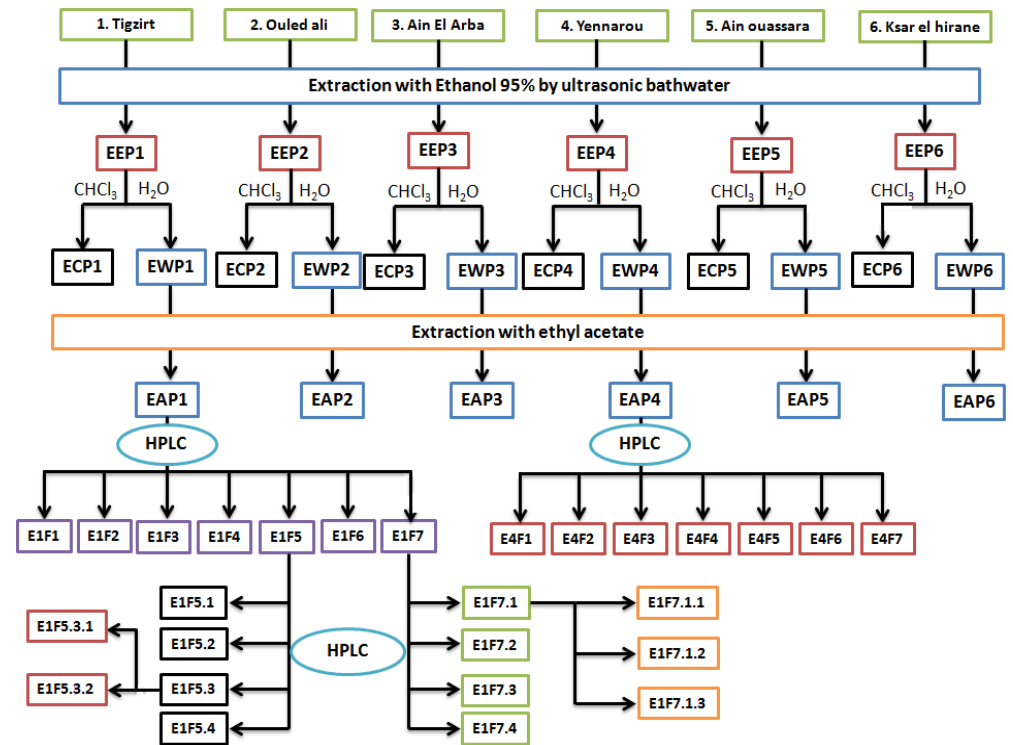
Figure 2. Extraction procedure and separation pathway for the propolis